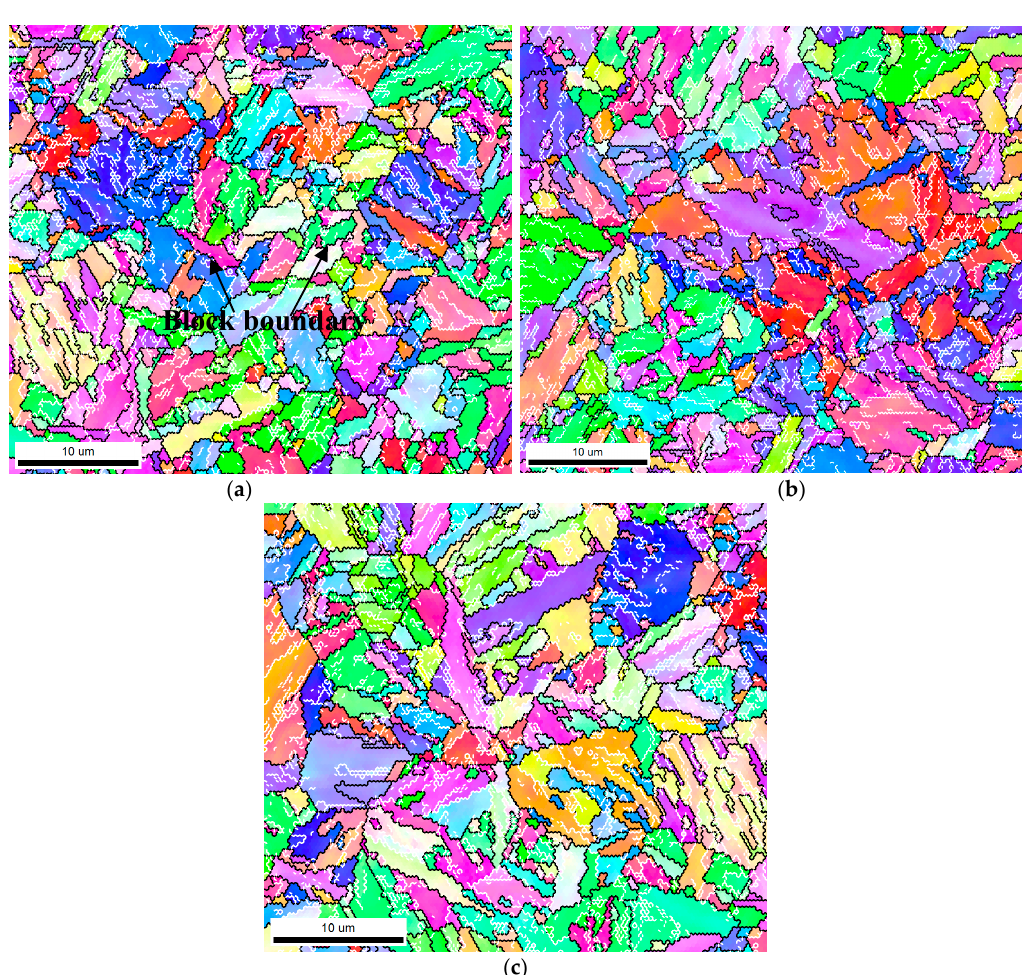
Figure 8. Typical electron back-scattered diffraction (EBSD) orientation maps showing martensitic packet and block in Q&T–treated samples at differing T t of ( a ) 650; ( b ) 700 and ( c ) 720 ° C .